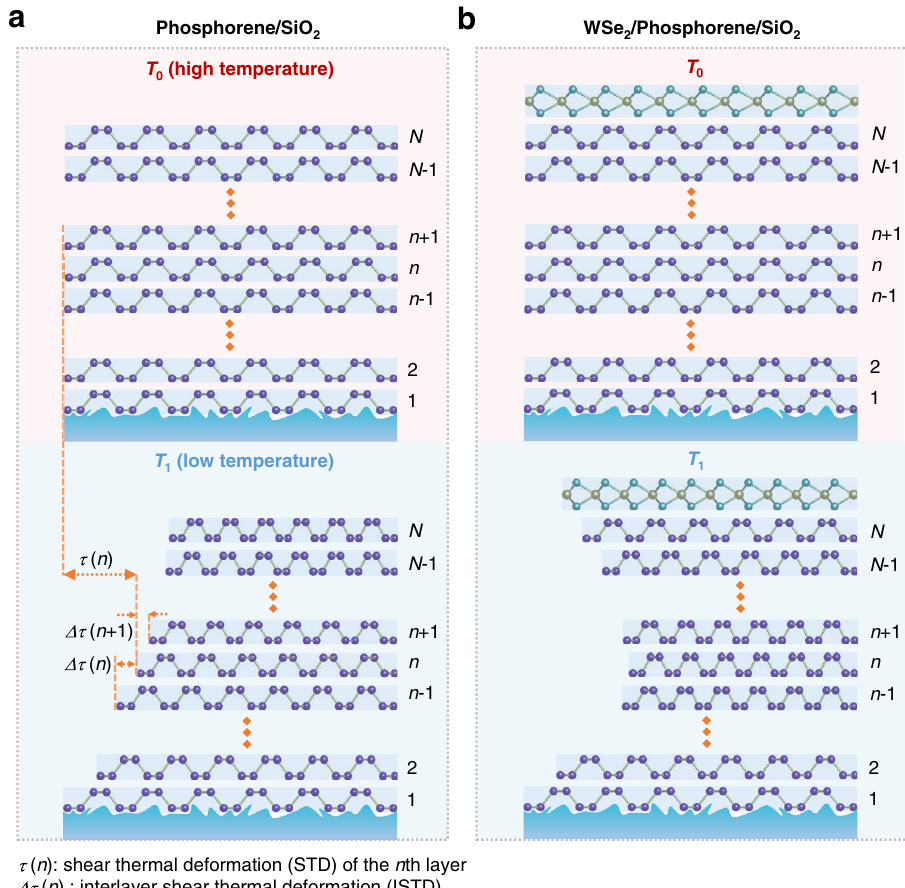
Fig. 1 Shear thermal deformation (STD) and interlayer shear thermal deformation (ISTD) in van der Waals materials and heterostructures. a ISTD model of an N -layer phosphorene/SiO 2 system when temperature decreases from T 0 to T 1 . b ISTD model of a WSe 2 / N -layer phosphorene/SiO 2 system when temperature decreases from T 0 to T 1 . Here, N is the total layer number of phosphorene. n is the n -th (1 ≤ n ≤ N ) phosphorene layer counting from bottom . τ ( n ) is the STD of the n- th phosphorene and Δτ ( n ) is the ISTD between the n -th and (n − 1)-th phosphorene from T 0 to T 1